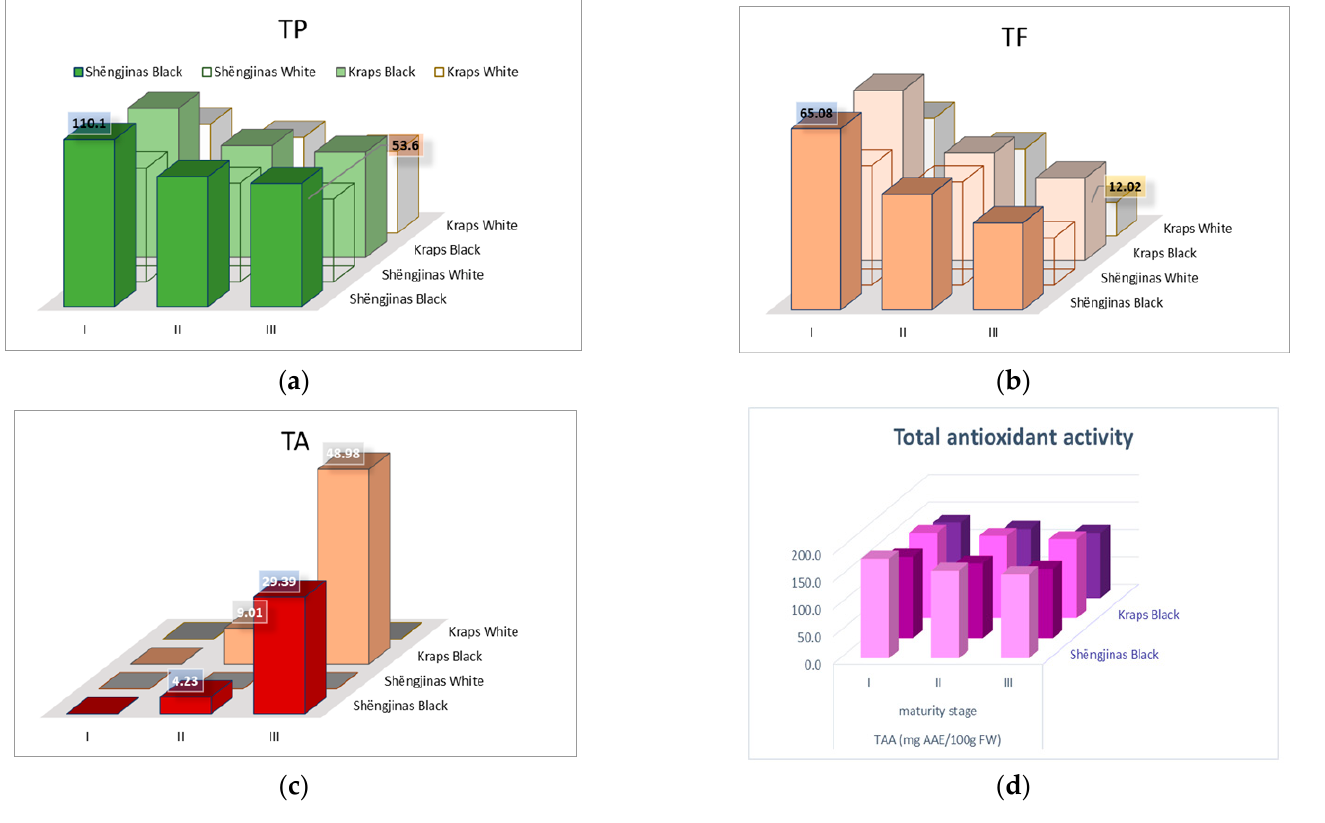
Figure 2. Shëngjinas and Kraps fig varieties (black and white) (g/100 g FW) in three maturity stages. ( a ) Total polyphenols (mg GAE/100 g FW); ( b ) total flavonoids (mg CE/100 g FW); ( c ) total antho- cyanins (mg C3G/100 g FW); ( d ) total antioxidant activity (mg AAE/100 g FW).